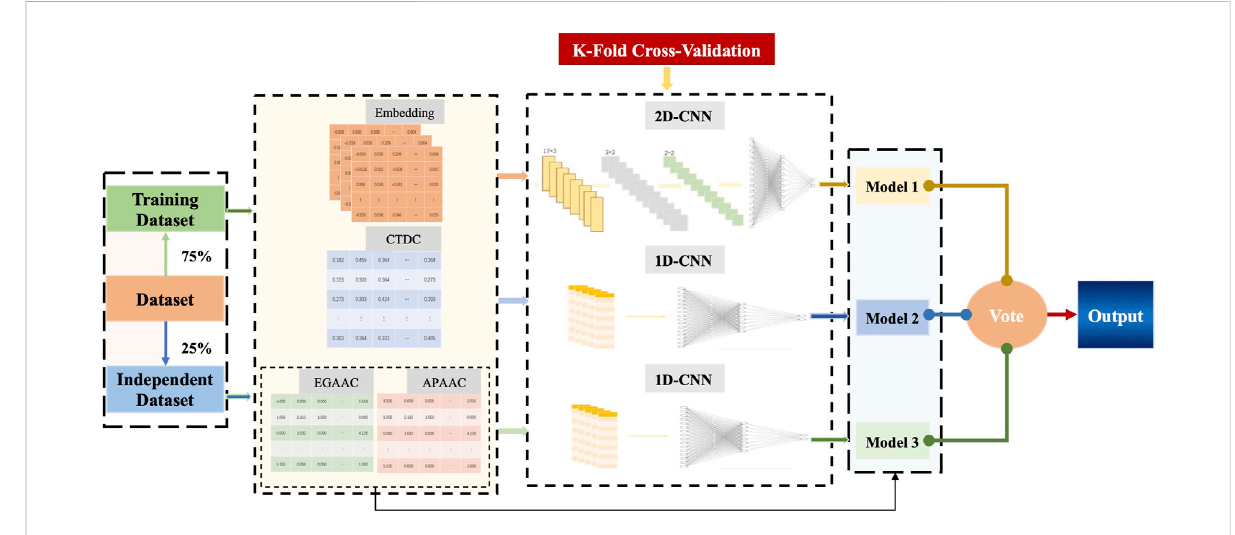
FIGURE 1 The overall framework of Deep_KsuccSite. The blue dashed line with arrows indicates the fl ow of the independent test